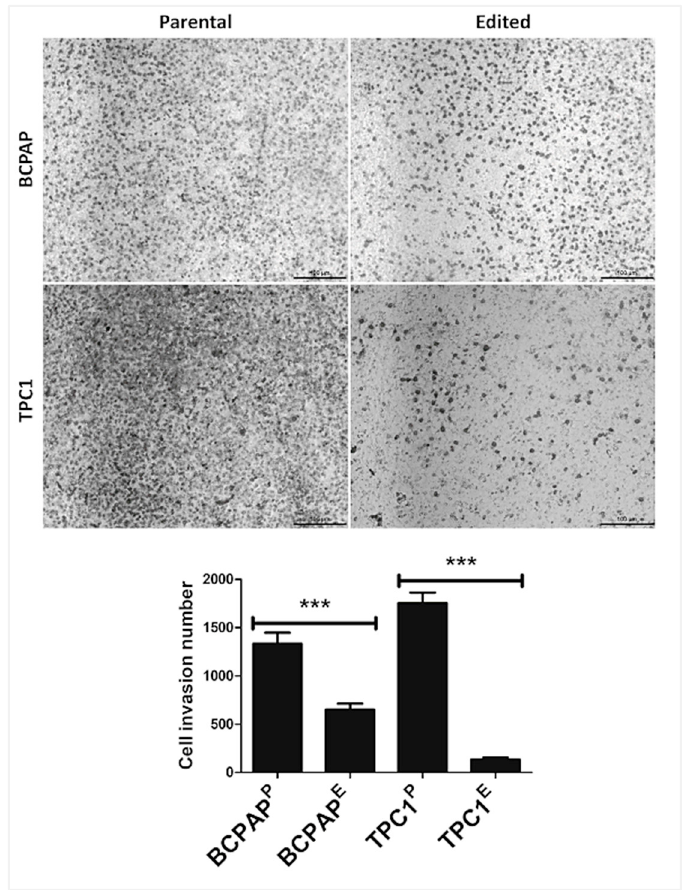
Figure 5. LIMD2 knockout in BCPAP and TPC1 cells showed reduced in vitro cell invasion. Representative images showed a reduced number of invasive cells in LIMD2-edited cells (BCPAP E and TPC1 E ) as compared with parental cell lines (BCPAP P and TPC1 P ). The data of three independent experiments showed that the percentage of invasive cells in BCPAP P (67%) and TPC1 P (88%) significantly reduced in BCPAP E (35%) and TPC1 E (7%). *** p < 0.001.